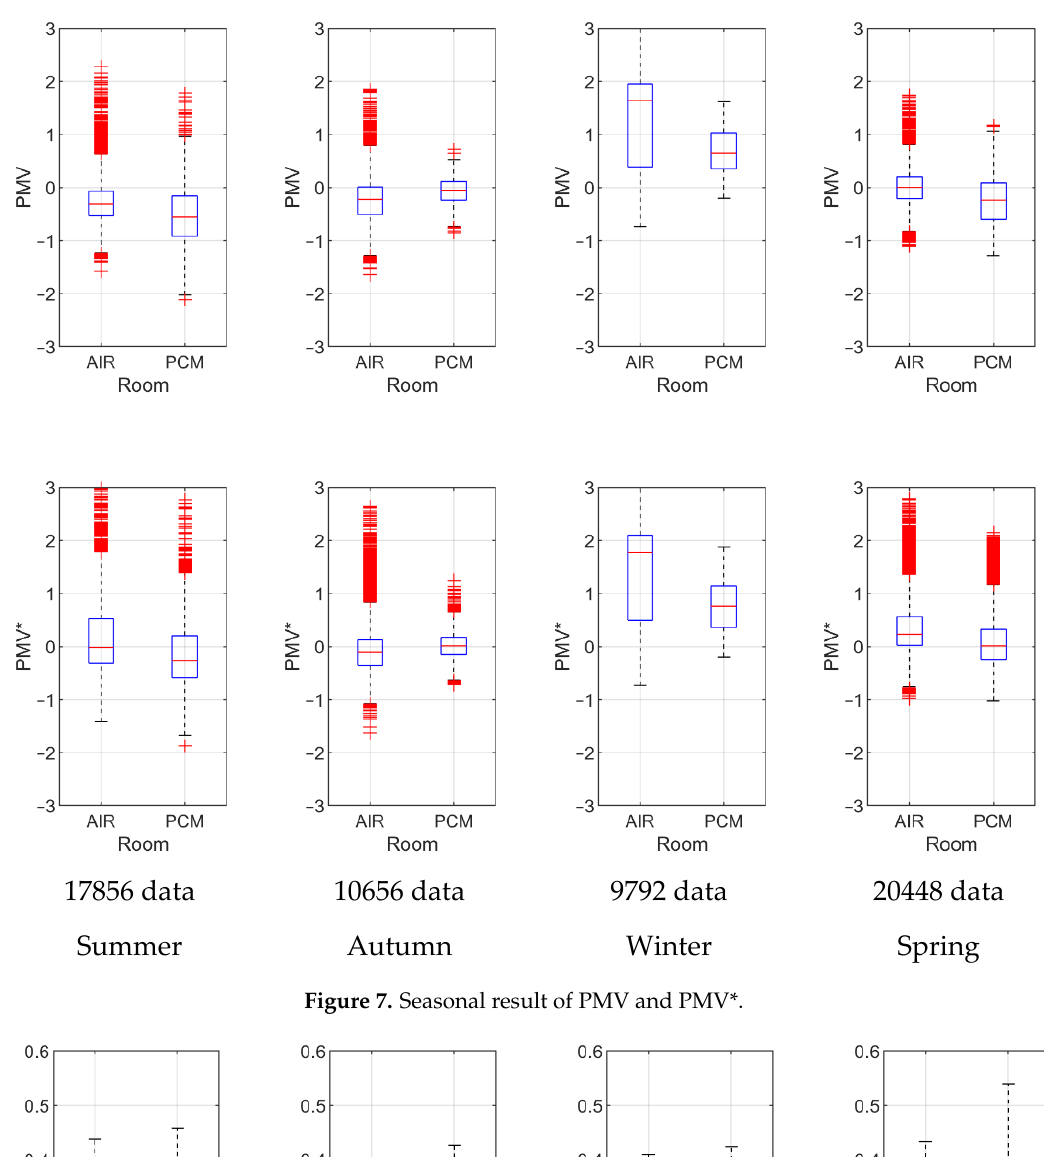
Figure 6. Seasonal result of daily energy consumption (EC). Winter is not included because of insufficient days with valid data.